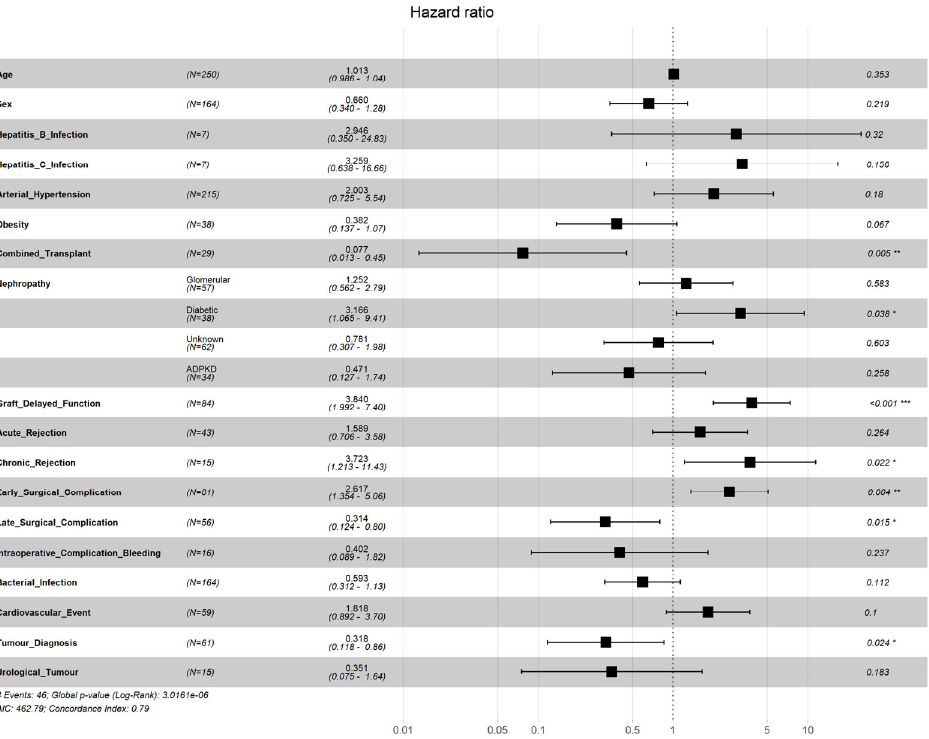
Figure 8. Results of the Cox proportional hazards model for graft survival, including the most significant studied variables. * p ‐ value < 0.05, ** p ‐ value < 0.01, *** p ‐ value < 0.001.